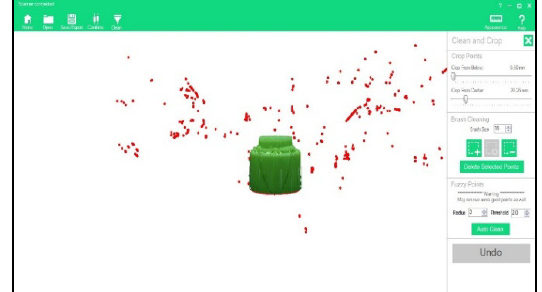
Fig. 6. Noise Points in Cylinder Case Study.